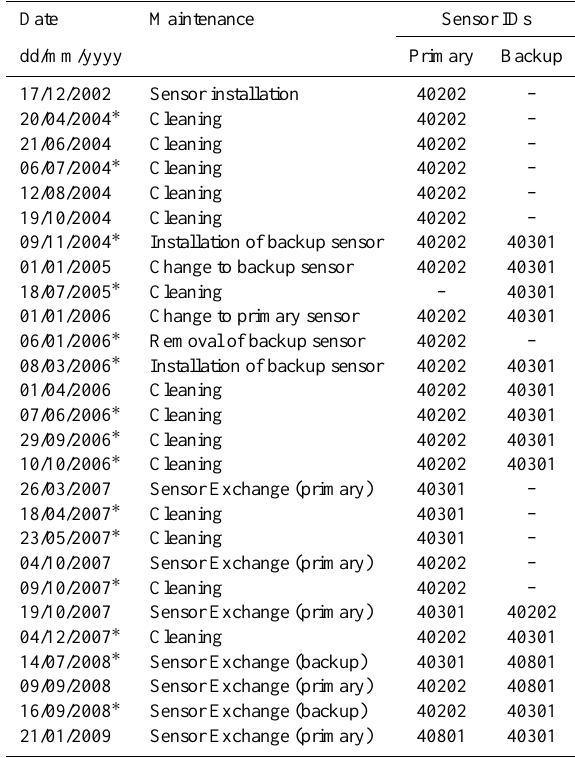
Table A1. Maintenance times of the water level pressure sensor between December 2002 and January 2009. Dates marked with a “*” were not used during the trend removal.